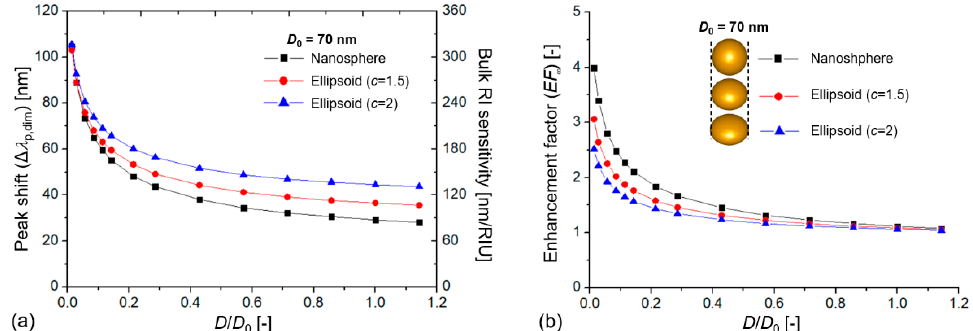
Figure 3. ( a ) Extinction peak shift of coupled plasmonic dimers ( ∆ λ p , dim ) and their calculated bulk refractive index sensitivity (RIS) as a function of the dimensionless D / D 0 value, where D is the interparticle distance, and D 0 is the particle diameter ( D 0 = 70 nm). ( b ) Calculated bulk enhancement factor ( EF ∞ ) values compared to single, uncoupled particles with the same size as a function of D / D 0 .